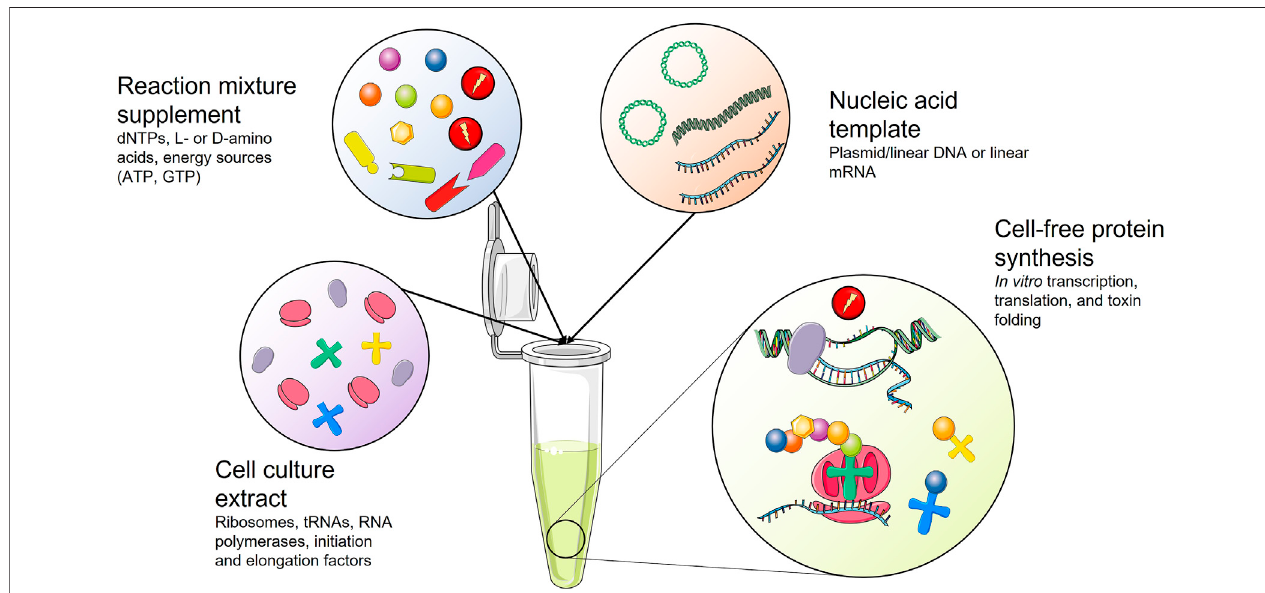
FIGURE 8 | Schematic representation of a cell-free protein synthesis (CFPS) system. Cell culture extract is supplemented with essential reagents for protein synthesis. Upon addition of a nucleic acid template coding for the toxin of interest, the toxin gene is transcribed and translated into a toxin that might need assisted